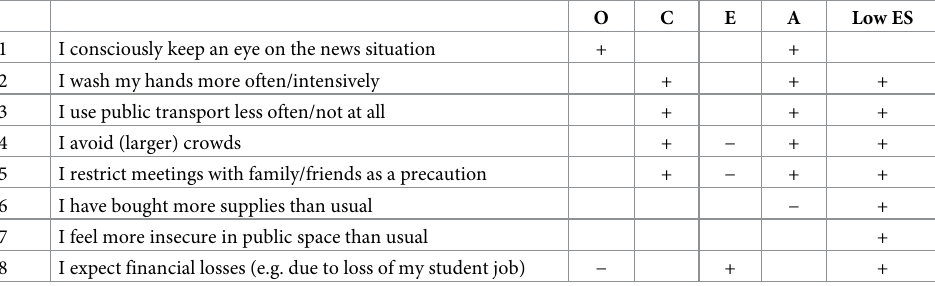
Table 1. Hypothesized associations between the Big Five personality traits and students’ thoughts, feelings, and behaviors during the first three weeks of the COVID-19 pandemic in Germany. O C E A Low